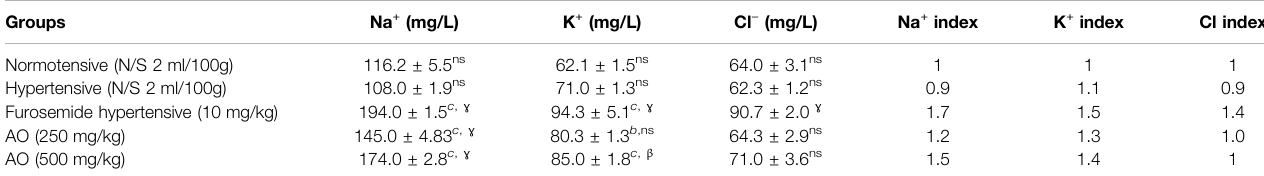
TABLE 8 | Effect of administration of Alpinia of fi cinarum on urinary electrolytes of chronic obesogenic diet-fed hypertensive rats at 24 h on the last day of the model. Groups Na + (mg/L) K + (mg/L) Cl − (mg/L) Na + index K + index Cl index Normotensive (N/S 2